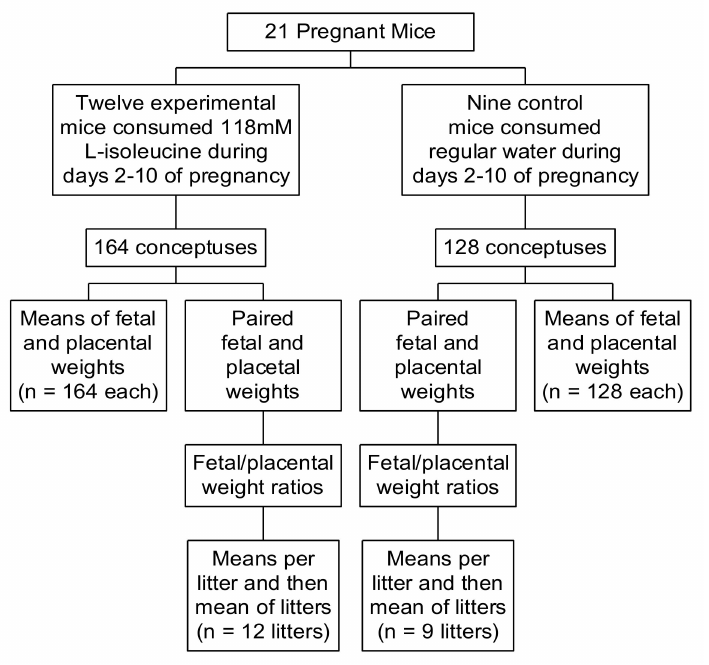
Figure 1. The experimental (E) and control (C) mice that underwent caesarian sections on day 18 of pregnancy.